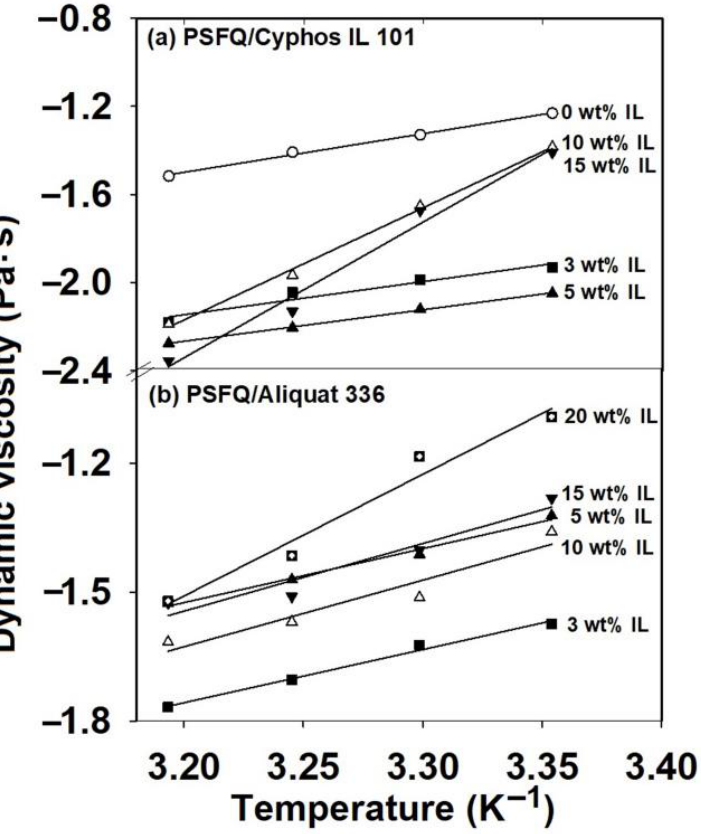
Figure 4. Dependence of the dynamic viscosity on temperature for ( a ) PSFQ/Cyphos IL 101 and ( b )PSFQ/Aliquat 336 systems at various mixing ratios.